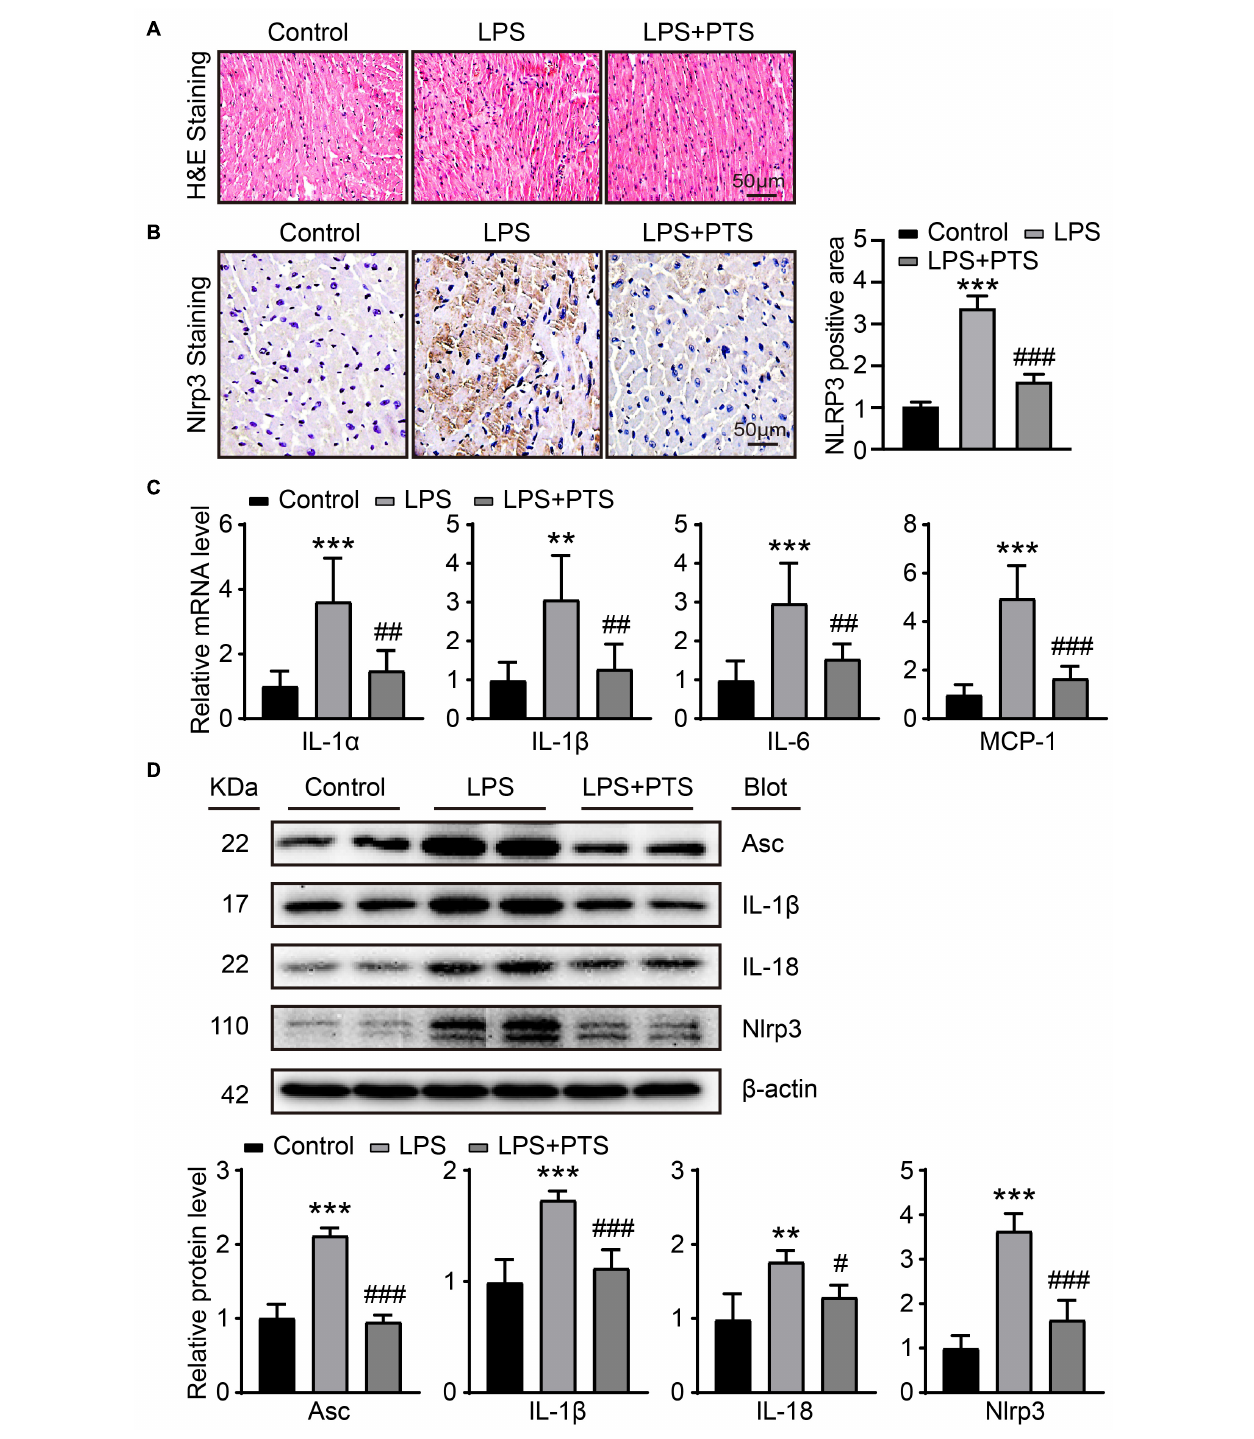
FIGURE 2 | PTS inhibits inflammation in the hearts of mice with LPS-Induced septic mice. (A) Representative H&E images of heart tissue from control group, LPS group, and LPS + PTS group. (B) Representative NLRP3 of IHC from control group, LPS group, and LPS + PTS group on the left and quantitative data are shown on the right ( n = 6). (C) The mRNA levels of IL-1 α , Il-1 β , IL-6, and MCP-1 in heart tissue from control group, LPS group, and LPS + PTS group were detected by qPCR ( n = 6). (D) Expressions of ACS, IL-1 β , Il-18, and NLRP3 protein in heart tissue were measured by Western blotting analysis ( n = 4). ** P < 0.01, *** P < 0.001 control vs. LPS, # P < 0.05, ## P < 0.01, ### P < 0.001 LPS vs. LPS + PTS.